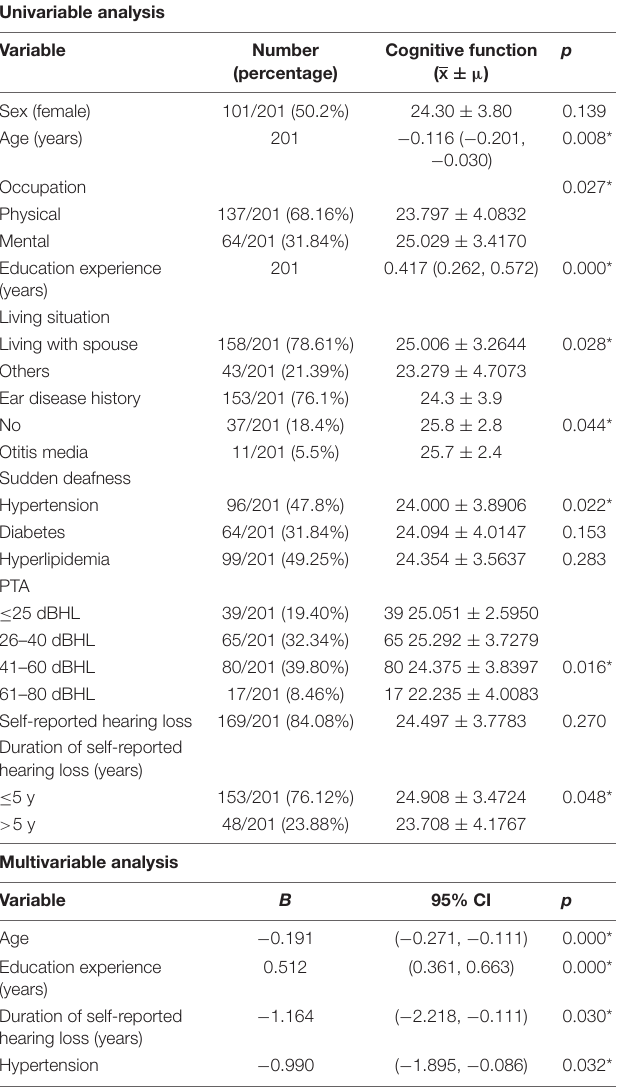
TABLE 1 | Factors related to cognitive function among the